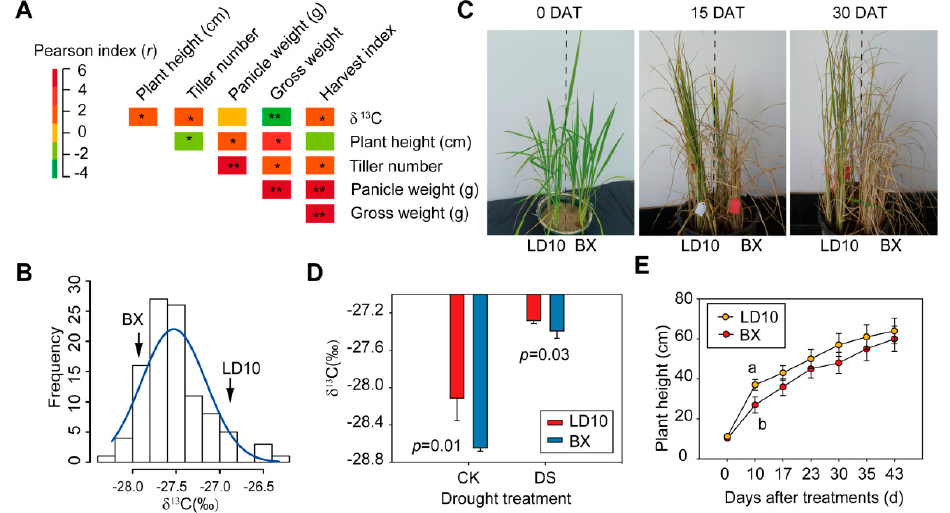
Figure 2. δ 13 C strongly correlates with drought resistance. ( A ) Pearson correlation coefficient among different morphological traits and physiological traits in 102 accessions. ( B ) Distribution of δ 13 C in 102 rice accessions. Two rice accessions with contrasting δ 13 C were selected to evaluate the drought stress (DS) resistance. ( C ) Images of LD10 and BX plants exposed to drought treatments after different days (DAT). ( D ) Comparison of δ 13 C between LD10 and BX at 10 DAT. Values represent mean ± standard deviation ( n = 3). ( E ) Plant height compared between LD10 and BX on different days after drought treatments. Values represent mean ± standard deviation ( n = 6). Student’s t -test was used to represent the significant levels, where different letters stand for significant levels at p < 0.05. *, ** Significant at p < 0.05 and p < 0.01,